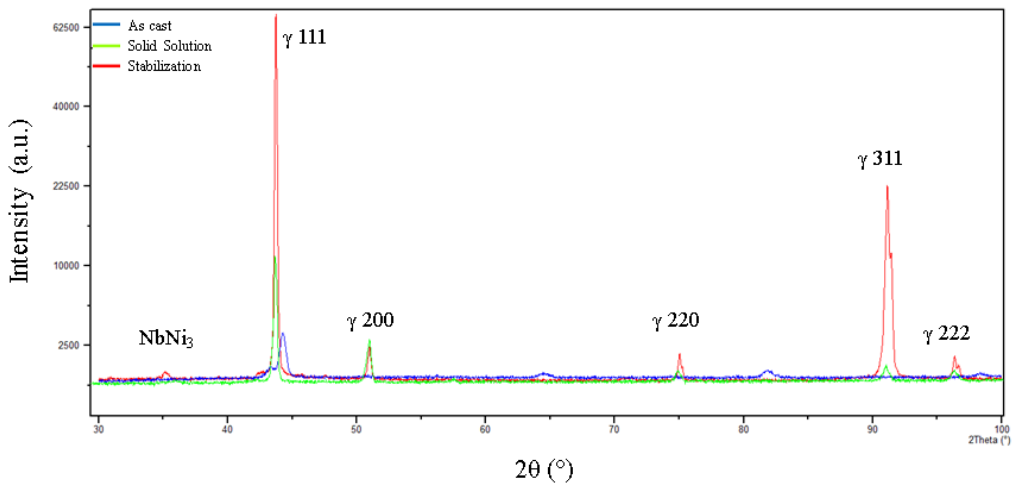
Figure 2. X-ray diffraction images of the samples (as cast, solid solution heat treated and stabilization heat treated).